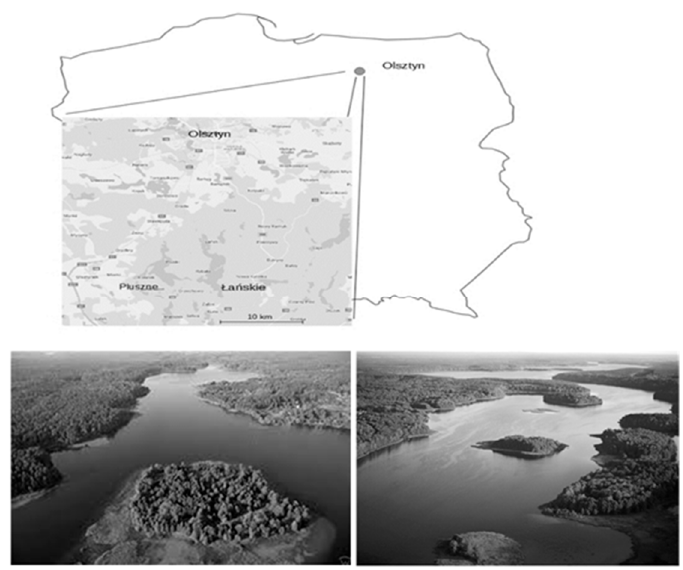
Figure 1. The study area was located in north-eastern Poland, near the city Olsztyn.